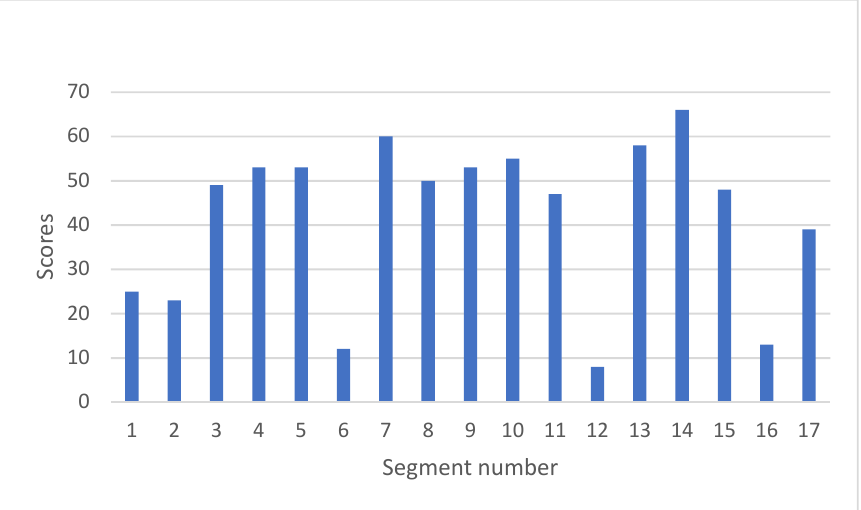
Figure 7. Summed-up Heart Risk View-S scores of 123 I-BMIPP. All the scores of each segment were summed up for 100 patients. Segment 1 to 6 configures basal ring, segment 7 to 12 configures mid-cavity ring, segment 13 to 16 configures apical ring, and segment 17 is apex, as nomenclated by AHA [10].